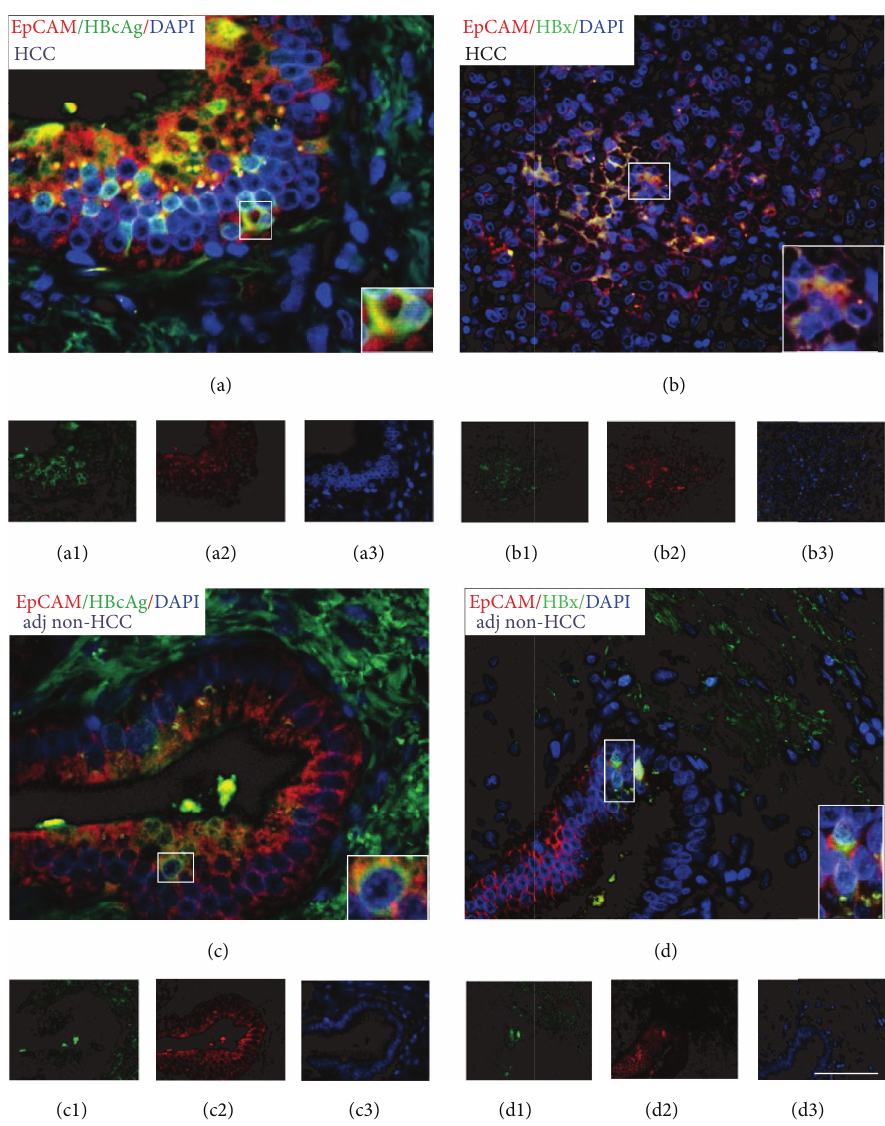
Figure 1: Immunofluorescence and confocal images of hepatitis B virus core antigen (HBcAg) and hepatitis B virus x protein (HBx) and the stem cell marker epithelial cell adhesion molecule (EpCAM) in human hepatocellular carcinoma (HCC) and adjacent nontumor tissues. Panel (a) overlay of HBcAg (red) and EpCAM (green) positive cells and DAP1 nuclei counterstaining (blue) in HCC tissue (panels (a1)–(a3), resp.). Insert: confocal image of HBcAg and EpCAM positive staining cell. Panel (b): overlay of HBx (red) and EpCAM (green) positive cells and DAP1 nuclei counterstaining (blue) in HCC tissue (panels (b1)–(b3), resp.). Insert: confocal image of HBx and EpCAM positive staining cell. Panel (c): staining of adjacent nontumor tissue for the same proteins described in panel (a). EpCAM positive staining cells were located in close proximity to the portal tracts of the liver lobule. Panel (d): staining of adjacent nontumor tissue for the same proteins described in panel (b). Magnification 40x and 60x